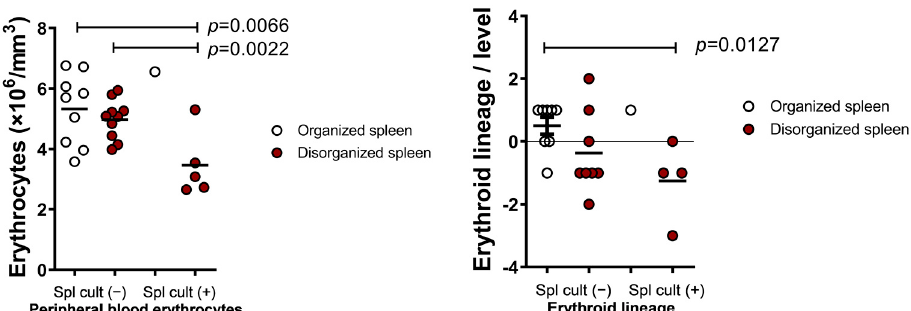
7 of 12 Figure 2. Changes in leukogram presented by dogs with active infection by L. infantum (Mann– Whitney). 3.3. Bone Marrow Changes in Dogs with Active L. infantum Infection Eight out of fourteen (57%) dogs with a positive splenic culture had detectable L. infantum DNA in the bone marrow. Among 32 dogs without positive splenic cultures, only 3 had detectable L. infantum DNA in the bone marrow ( p = 0.0004). The histological char- acteristics of the bone marrow from the dogs studied are shown in Table 2. Bone marrow